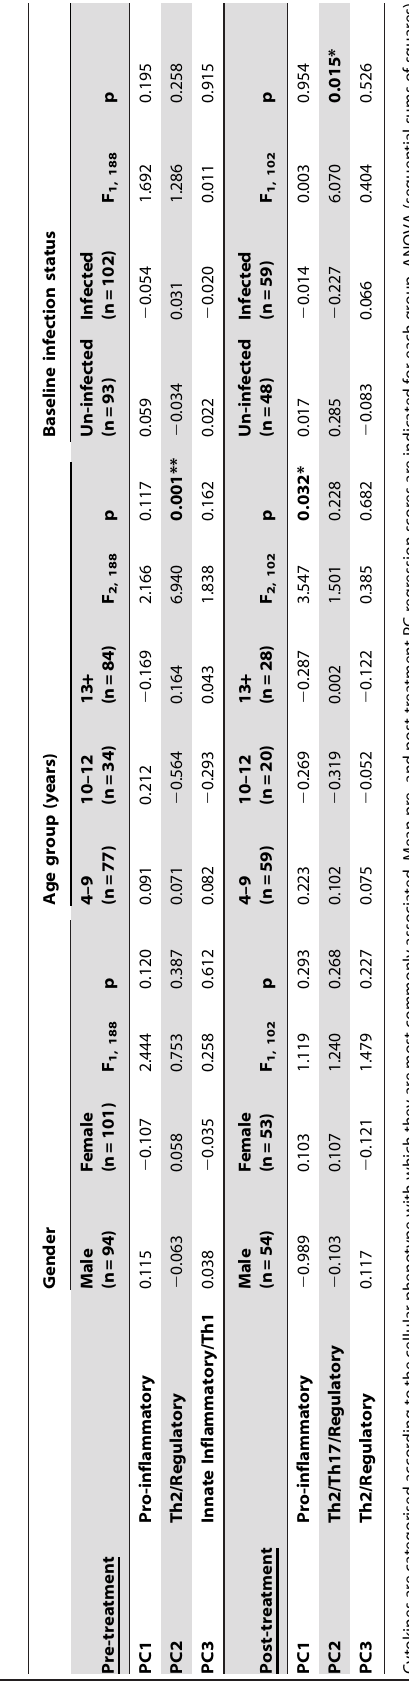
with Th2, regulatory and Th17 cells (PC2; 13.2% of variance), and a profile that was positively associated with the type 2 effector cytokine IL-5 and negatively associated with the regulatory cytokine IL-10 (PC3; 10.0% of variance). Post-treatment PC1 significantly differed according to participant age group (Figure 4, Table 3; F 2, 102 : 3.547, p= 0.032) with the youngest participants having significantly higher scores than those in the 10–12 (Mean difference: 0.516, p = 0.049) or 13 + age groups (Mean difference: 0.508, p= 0.026). Post-treatment PC2 scores significantly differed according to infection status at baseline and were lower in participants with patent infection at the time of treatment than in their schistosome-negative counterparts (Figure 4, Table 3; F 1, 102 : 6.070, p= 0.015), suggesting that the presence of live parasites at the time of treatment influenced levels of Th2, Th17 and regulatory type cytokines 6 weeks later. PC3 scores were not significantly affected by participant gender, age group or pre- treatment infection status (Figure 4, Table 3).